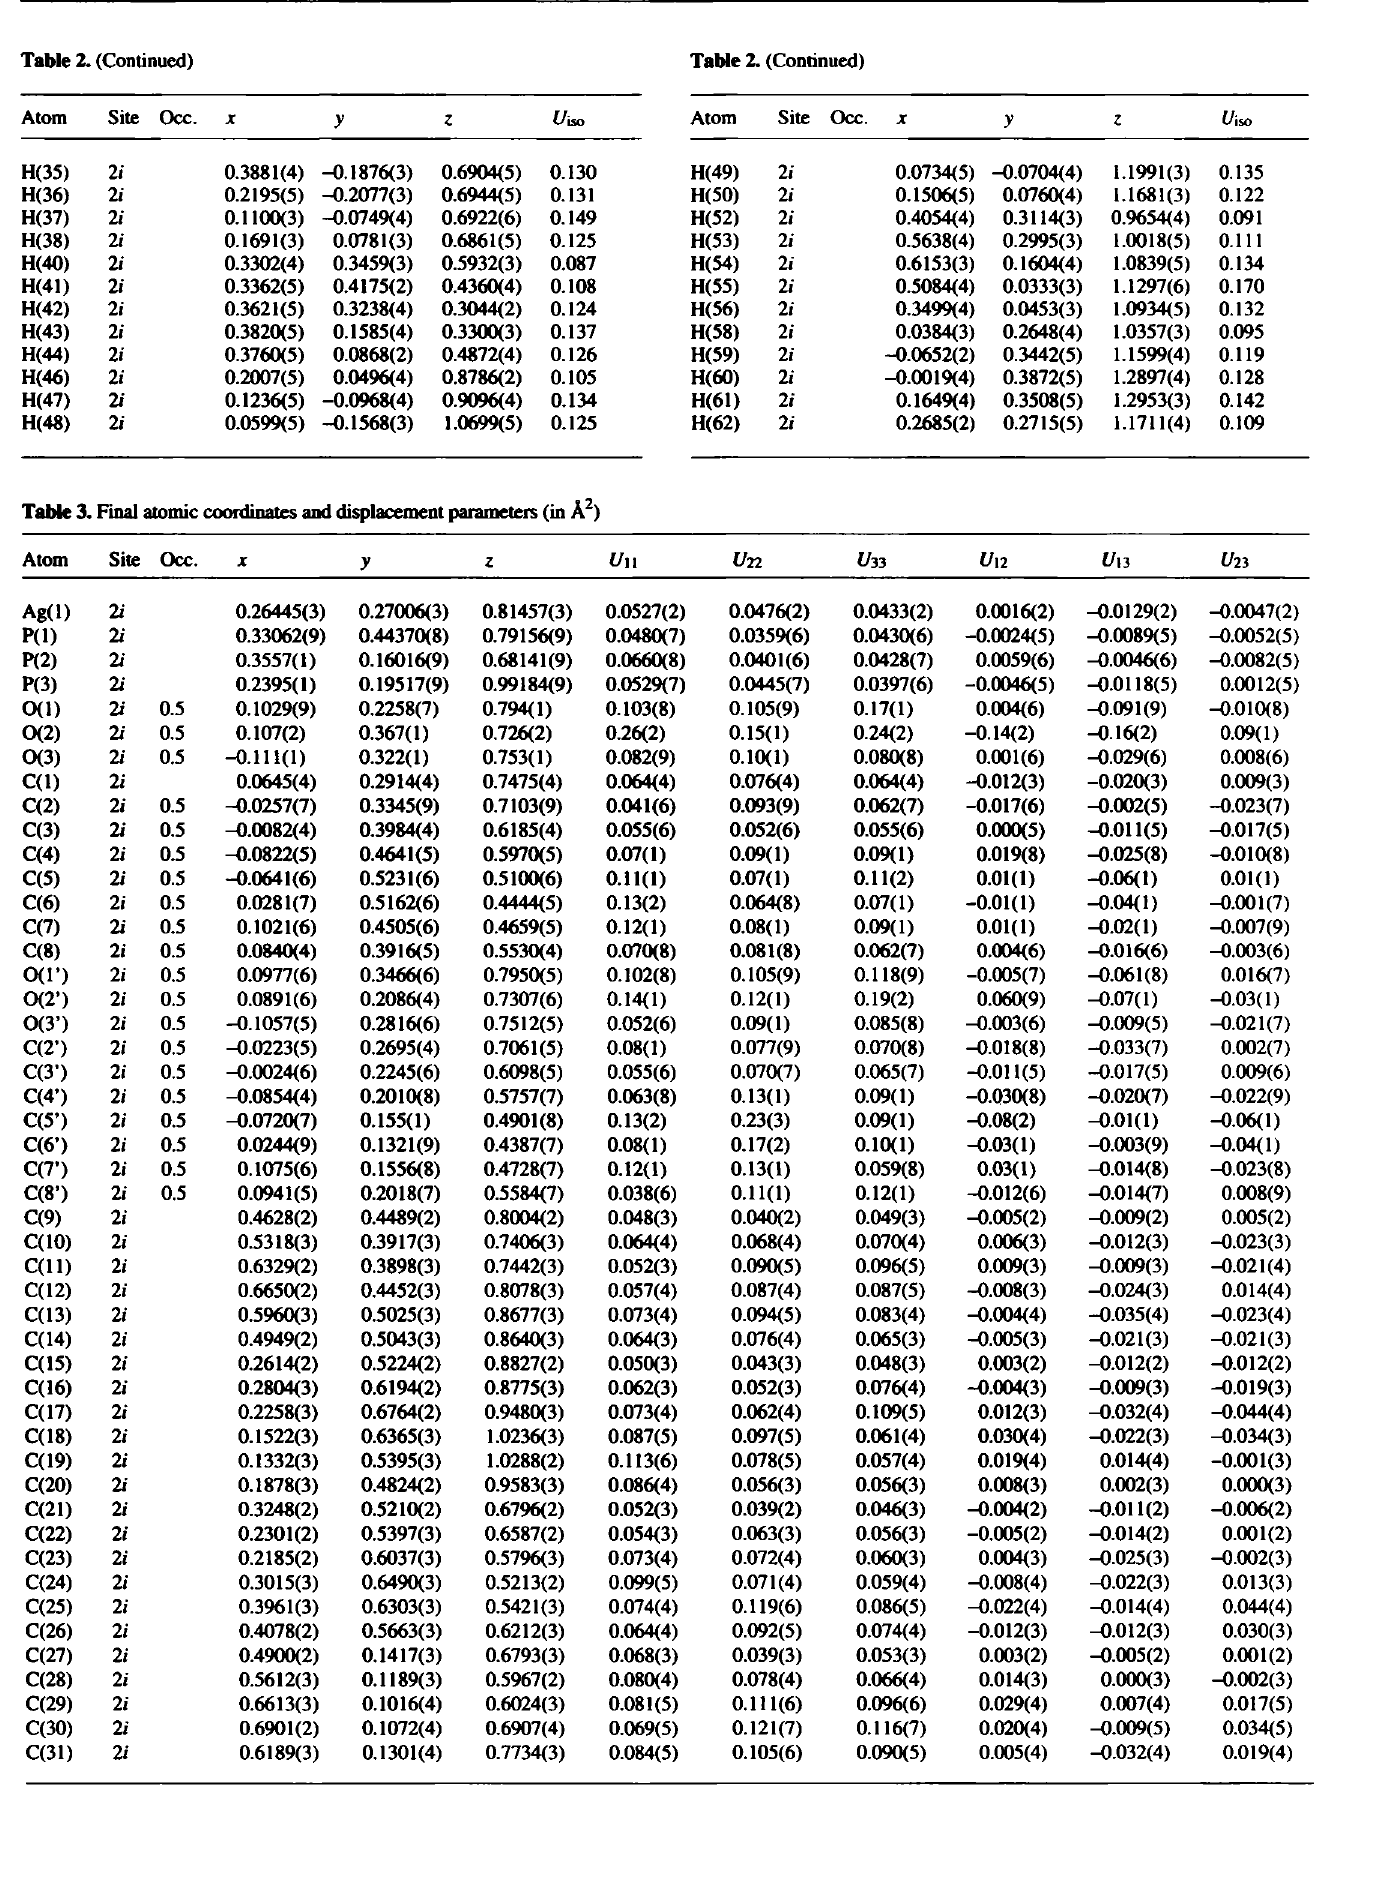
Table 3. Final atomic coordinates and displacement parameters (in Ä 2 ) Atom Site